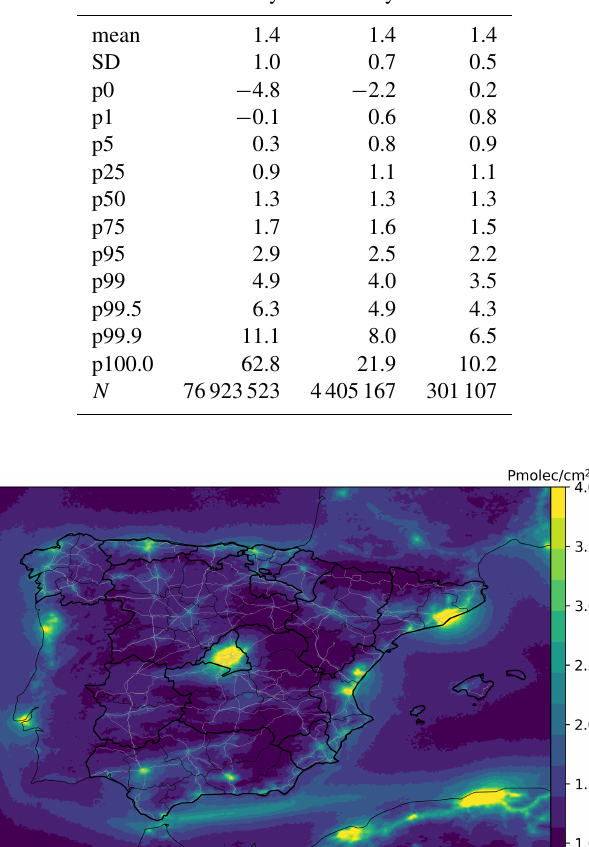
Table 2. Distribution of TrC-NO 2 values (in Pmoleccm − 2 ) over the Iberian Peninsula (Spain and Portugal) at daily, monthly and annual scales. Metric Daily Monthly Annual